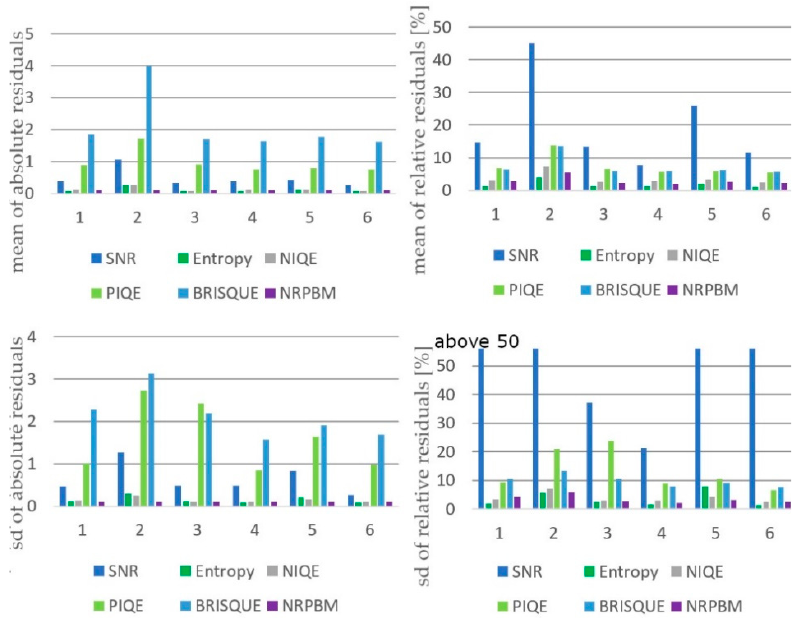
Figure 9. Mean value and standard deviation of absolute and relative deviations for SNR, Entropy, NIQE, PIQE, BRISQUE, and NRPBM for each of the six options .